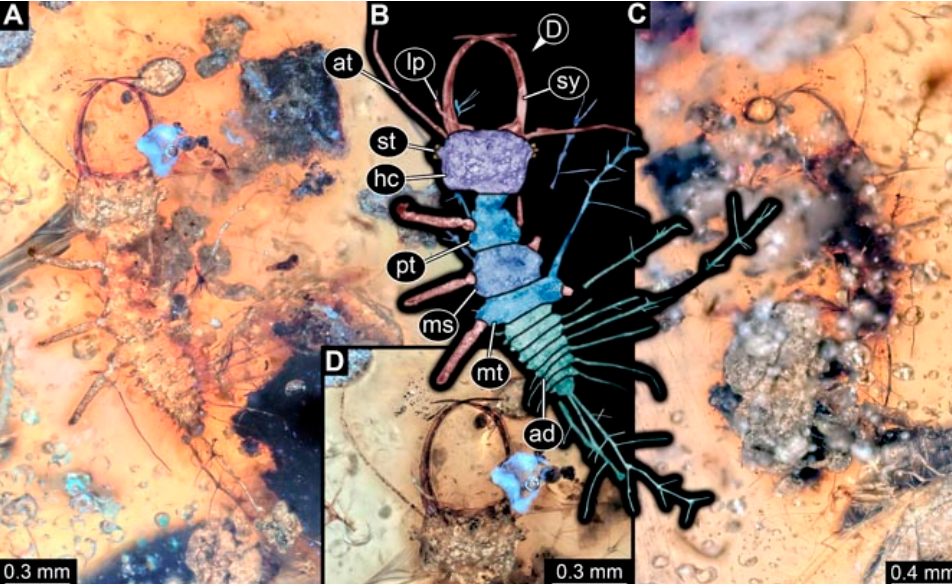
Figure 37. Specimen 4863 (PED 1000); Myanmar amber. ( A ) Dorsal view. ( B ) Dorsal view, colour- marked. ( C ) Ventral view. ( D ) Close-up of head capsule in dorsal view. Abbreviations: ad = abdomen; at = antenna; hc = head capsule; lp = labial palp; ms = mesothorax; mt = metathorax; pt = prothorax; st = stemmata; sy = stylet.